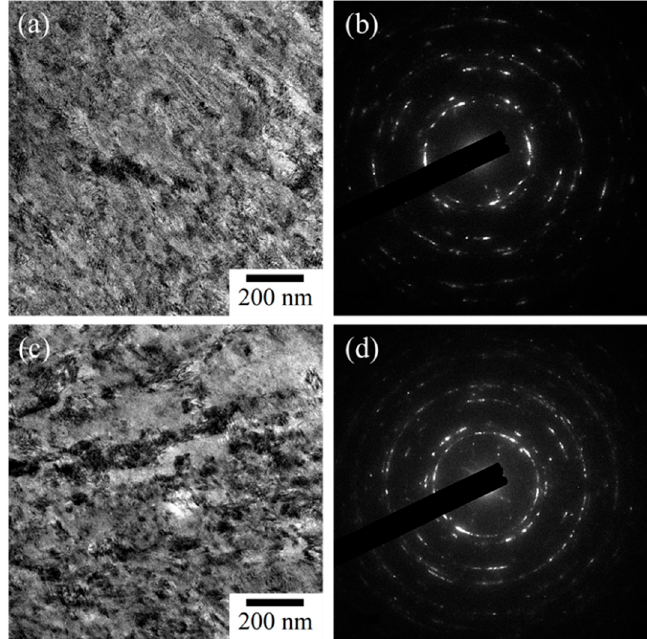
Figure 11. TEM images of specimens after erosion: ( a ) AE, ( b ) SAED pattern of AE, ( c ) HSAE, and ( d ) SAED pattern of HSAE.